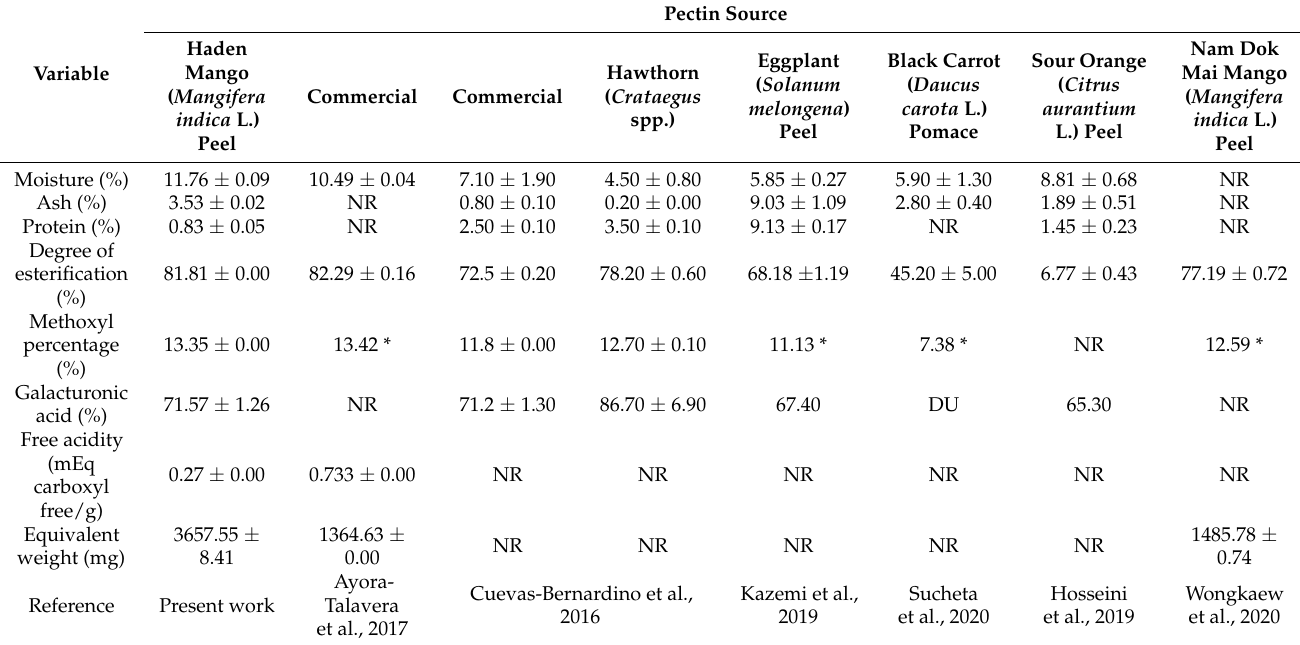
Table 5. Chemical and physicochemical parameters of Haden mango peel pectin compared to pectin from different sources.